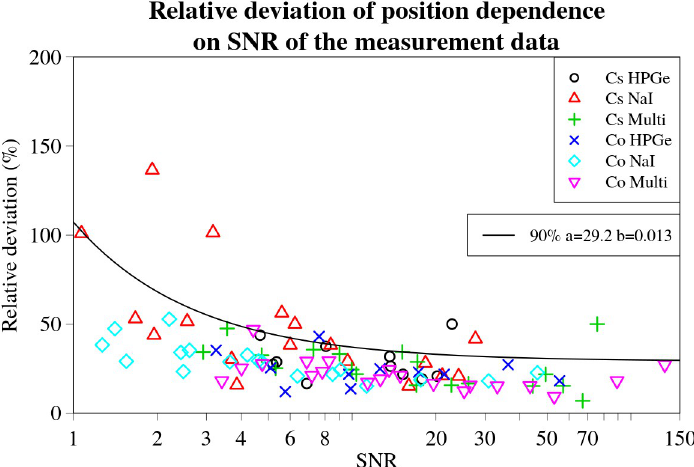
Fig 15. Position relative deviation values for every experimental set-up, detector and source combination plotted against the respective SNR values. Black line denotes a curve representing the 90% quantile dependency on the SNR of the data obtained using non-linear quantile regression. Fitted parameters a and b of the line are displayed in a legend on the right.